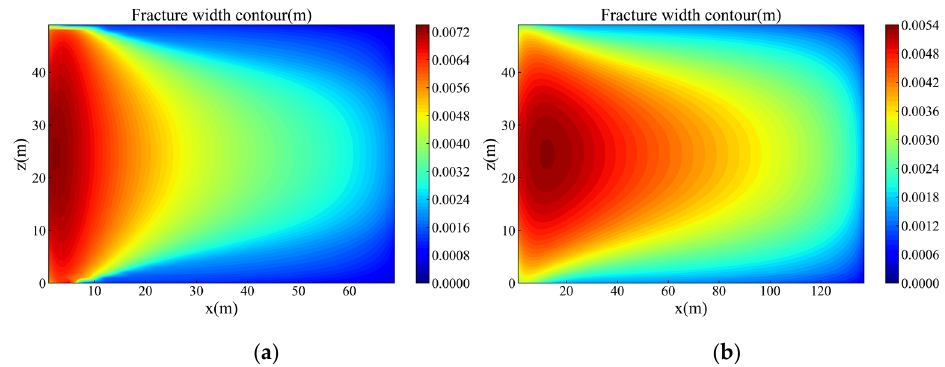
Figure 8. Two-dimensional acid-etched fracture width distribution by injection of plain acid and crosslinked acid (considering the variation in mass transfer coefficient with temperature). ( a ) plain acid, ( b ) crosslinked acid.